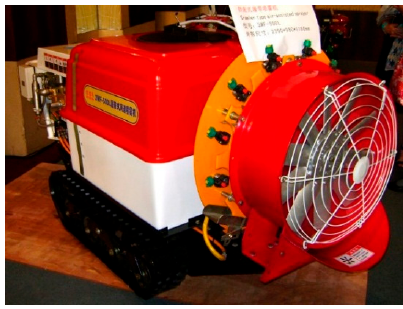
Figure 12. MAEC cassava lifter (Photo: Brian Sims).